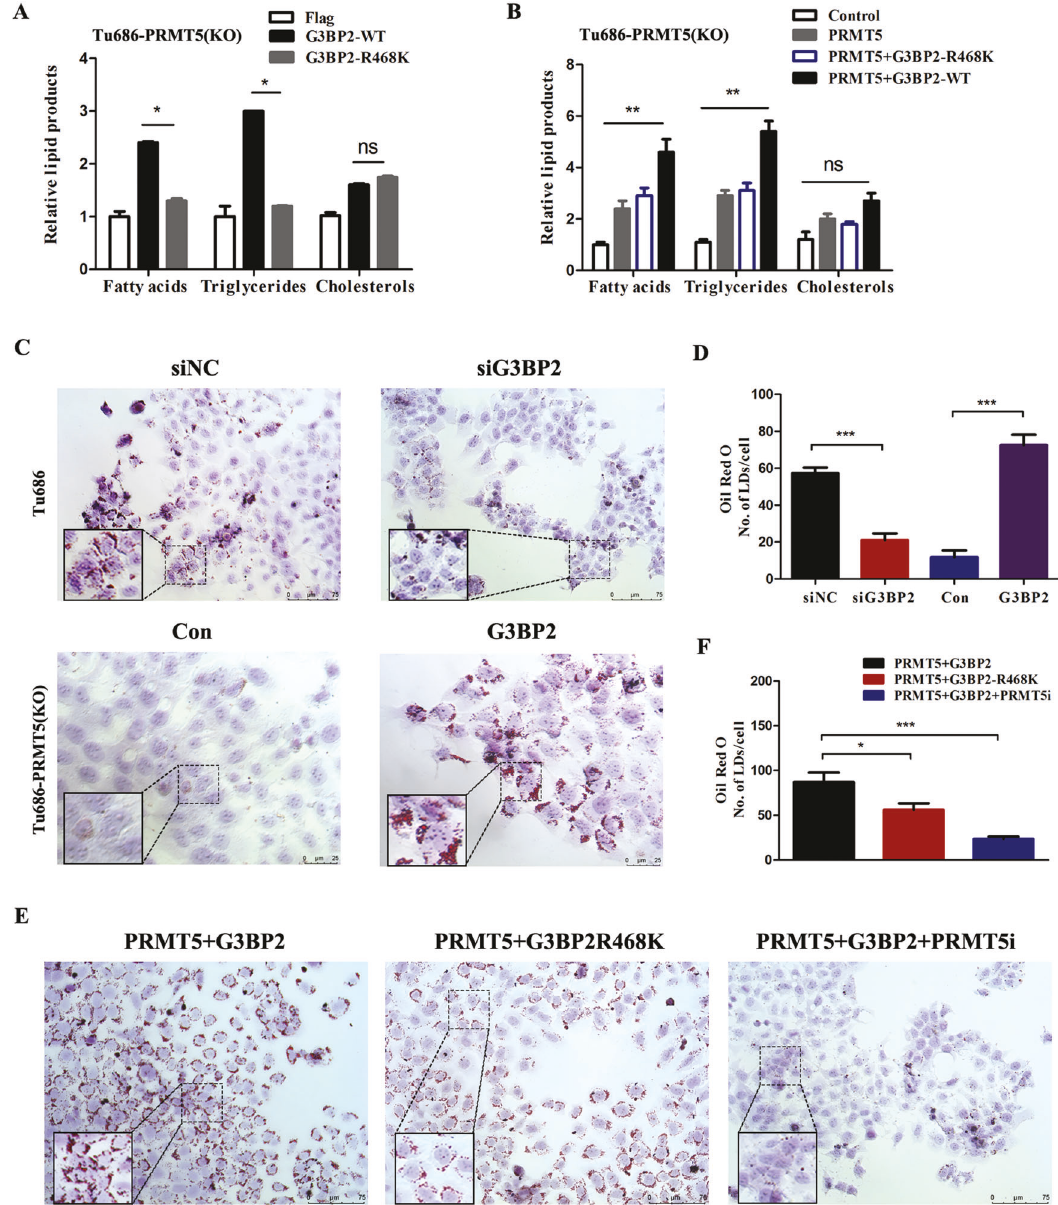
Fig. 5 G3BP2 methylation contributes to PRMT5-induced lipids synthesis. A , B The levels of triglycerides, fatty acids and cholesterols were measured after transfected with indicated plasmids, such as pcDNA3.1-G3BP2-WT, pcDNA3.1-G3BP2-R468K, pcDNA3.1-PRMT5, pcDNA3.1- PRMT5 + G3BP2-WT or pcDNA3.1-PRMT5 + G3BP2-R468K, in PRMT5-knockout Tu686 cells. C , D The effect of G3BP2 inhibition or overexpression on lipogenesis was determined by Oil Red O staining in Tu686 and PRMT5-knockout Tu686 cells. Quanti fi cation of lipid droplets were performed by Image J. Scale bar: 75 μ m, 25 μ m. E , F Representative images and quanti fi cation of G3BP2 or G3BP2R468K with or without PRMT5 on lipogenesis by Oil Red O staining in PRMT5-knockout cells. Scale bar: 75 μ m. PRMT5i for PRMT5 inhibitor. The data are presented as the mean ± SD; ns no signi fi cant difference, * P < 0.05; ** P < 0.01,*** P < 0.001. ectopic expression of G3BP2-WT increased PRMT5-mediated cell droplets formation (Fig. 5E, F). The above results demonstrating proliferation compared with the G3BP2-MUT (Fig. 6A, B). the synergistic activation of lipogenesis by PRMT5 and G3BP2. Additionally, the enhanced proliferation induced by overexpres- sion of G3BP2-WT was blocked when the absence of PRMT5, Stabilization of G3BP2 by PRMT5 and USP7 promotes suggesting that the methylation of G3BP2 is involved in the event tumorigenesis of carcinoma cells of PRMT5 promotes carcinoma cell growth (Fig. 6C, D). Moreover, Previous studies have shown that higher levels of G3BP2 status transwell and wound healing assays were used to con fi rm this correlated with malignant progression and poor prognosis [7], we observation. G3BP2-WT and PRMT5 co-transfected cells dramati- sought to con fi rm if it also occurs in a methylation-dependent cally promoted the migration and invasion, whereas the G3BP2- way. Hence, the function of PRMT5-G3BP2 interaction on R468K + PRMT5 and G3BP2-WT + siPRMT5 group cells presented tumorigenesis was further explored. In the USP7-stable Tu686 a little bit faster migration capacity than G3BP2-WT cells (Fig. 6E, cell lines, CCK-8 and colony formation assays showed that the